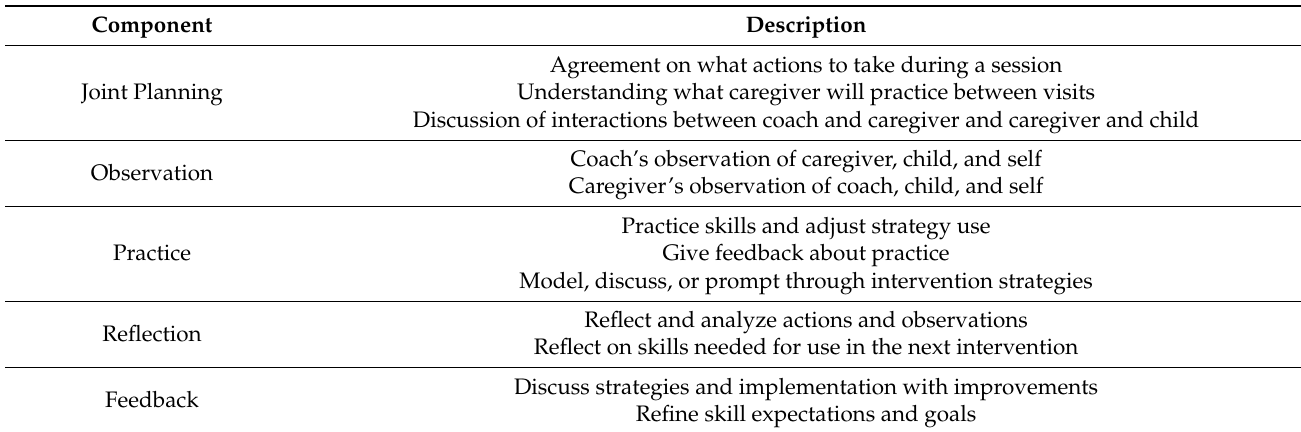
Table 4. Coaching